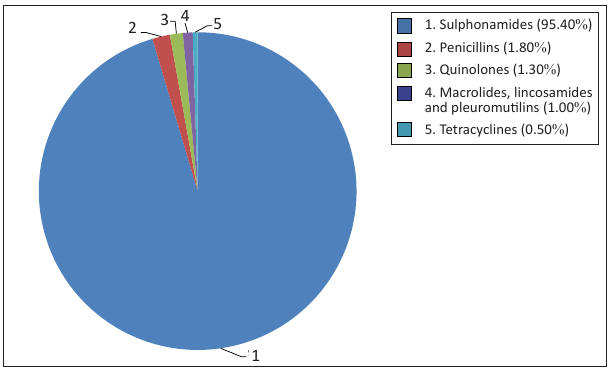
FIGURE 3: Percentages of volume (kg) antimicrobials sold for water medication during